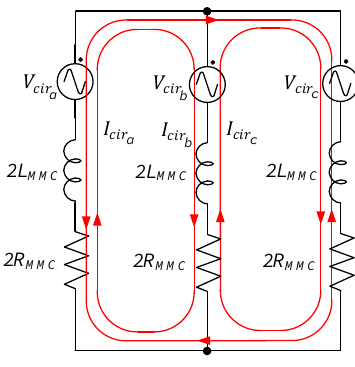
Figure 5. Circulating current flow model.